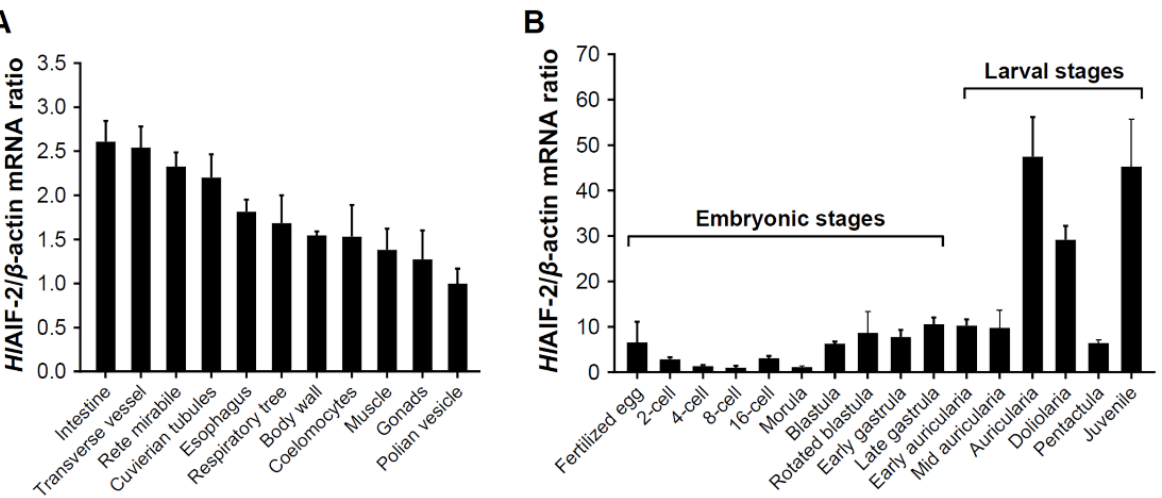
Figure 3. Expression patterns of Hl AIF-2. ( A ) Expression profile of Hl AIF-2 mRNA in different tis- sues. ( B ) Expression profiles of Hl AIF-2 mRNA during embryonic and larval stages. Data are pre- sented as the mean ± SE ( n = 3).